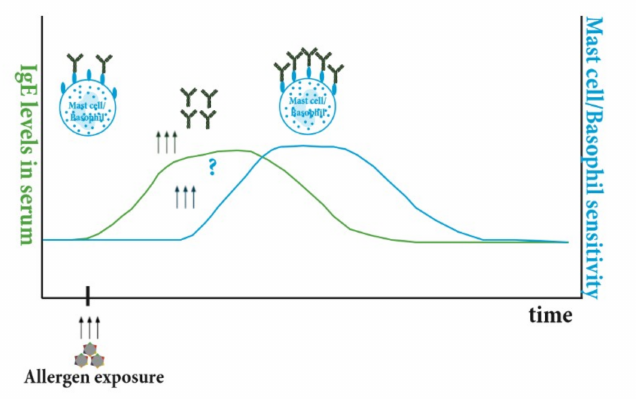
Figure 4. Timely interplay of rises in IgE levels and mast cell and basophil sensitivity. Upon allergen exposure there is a rise in allergen-specific IgE levels (green line) followed by an increase in basophil and mast cell sensitivity (blue